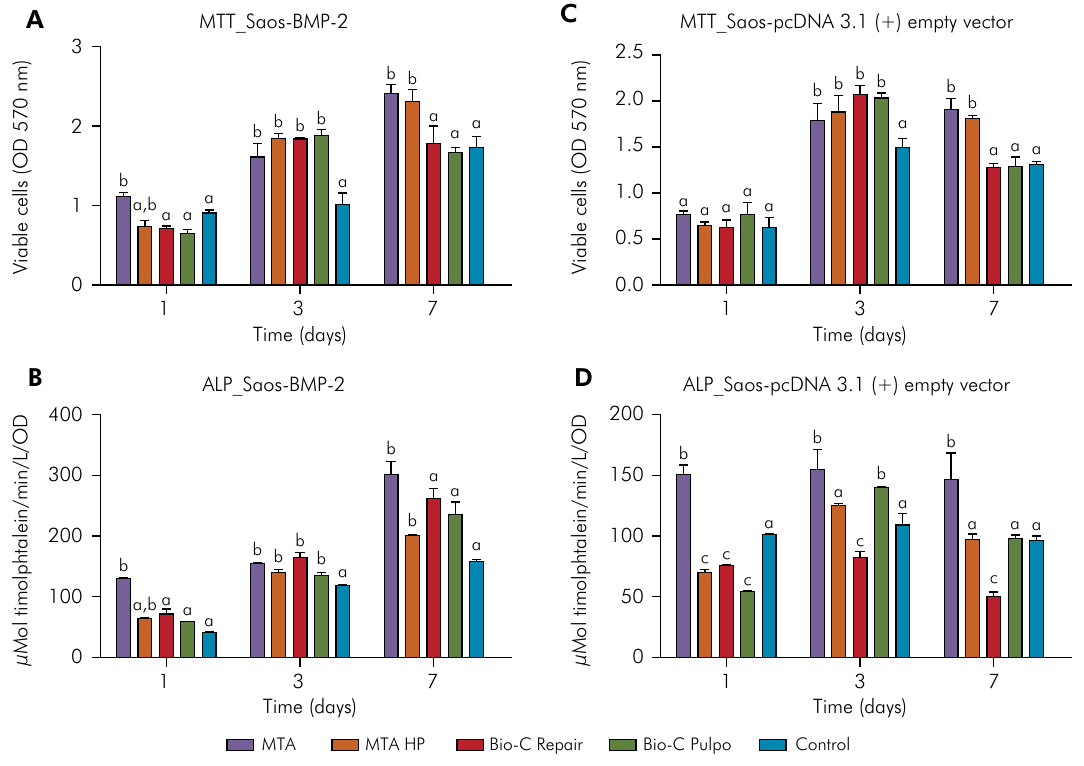
Bars with different letters represent significant differences among the groups. ANOVA, Bonferroni Control = cells exposed to serum-free culture medium. Figure 3. Cell viability and ALP evaluation. (a and b) Saos-BMP-2 transfected cells and (c and d) Saos-pcDNA 3.1 (+) empty vector after exposure to MTA, MTA HP, Bio-C Repair, Bio-C Pulpo at 1:12 dilution, and to culture medium (control) for 1, 3 and 7 days, respectively. Three independent experiments were performed in sextuplicate for each experimental group and outcome (n = 3/group).